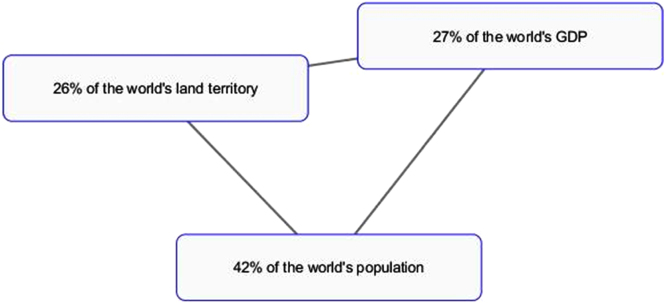
Infographics “BRICS in Numbers” [1].